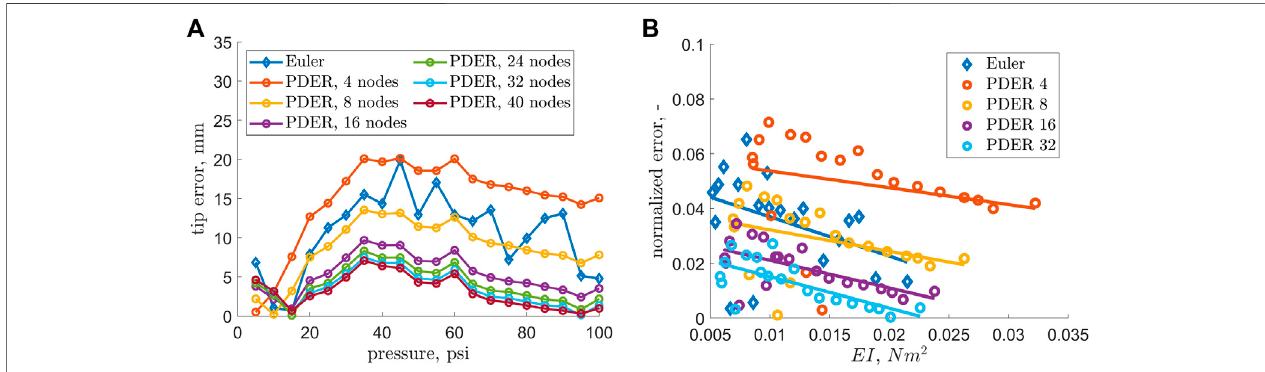
FIGURE6|(A) TipdisplacementerrorasanormofCartesiancoordinatesrelativetotheexperimentaltippositions. (B) TipdisplacementerrornormalizedbyEFAM length as a function of bending stiffness. The markers represent data points, and the solid lines represent least squares linear fi t to the data points. Only four out of six PDER models are shown for